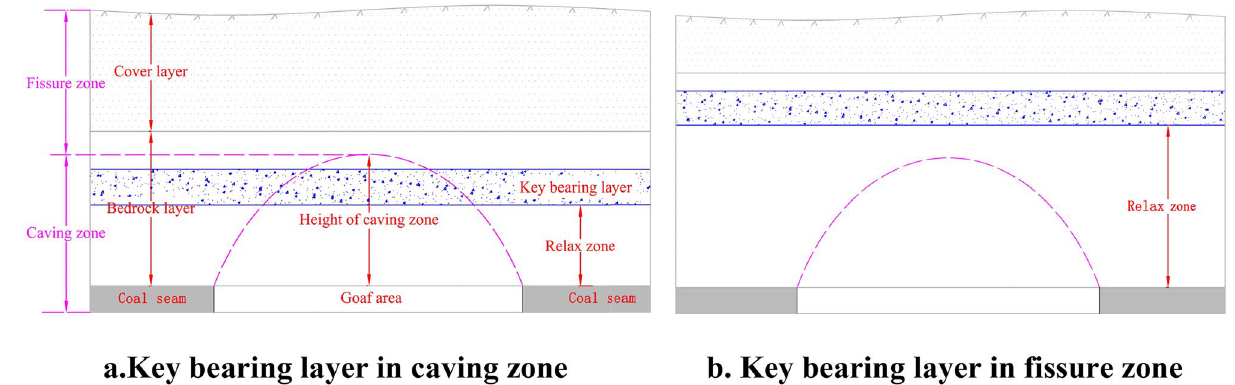
Figure 2. Classification of the occurrence conditions in the overburden rock for shallow thick seam